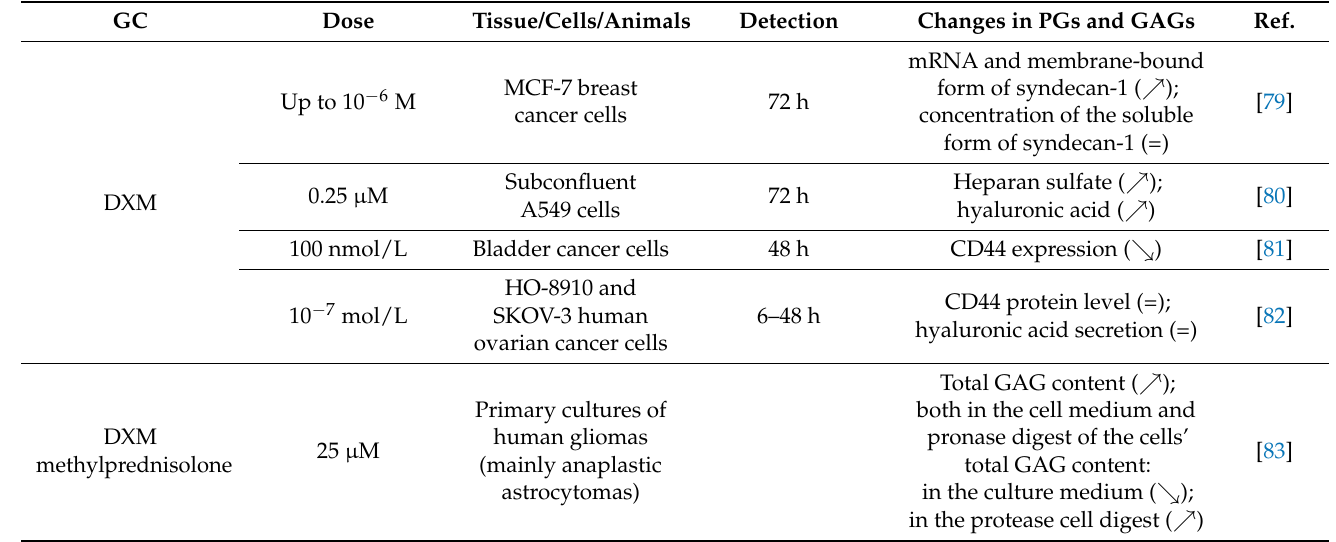
Table 2. Effects of glucocorticoids on PG expression and GAG content in malignant tissues and cells. Arrows correspond to upregulation ( (cid:37) ) or downregulation ( (cid:38) ) of the PG core protein expression or total PG/GAG content, (=)—no change in the studied parameters.